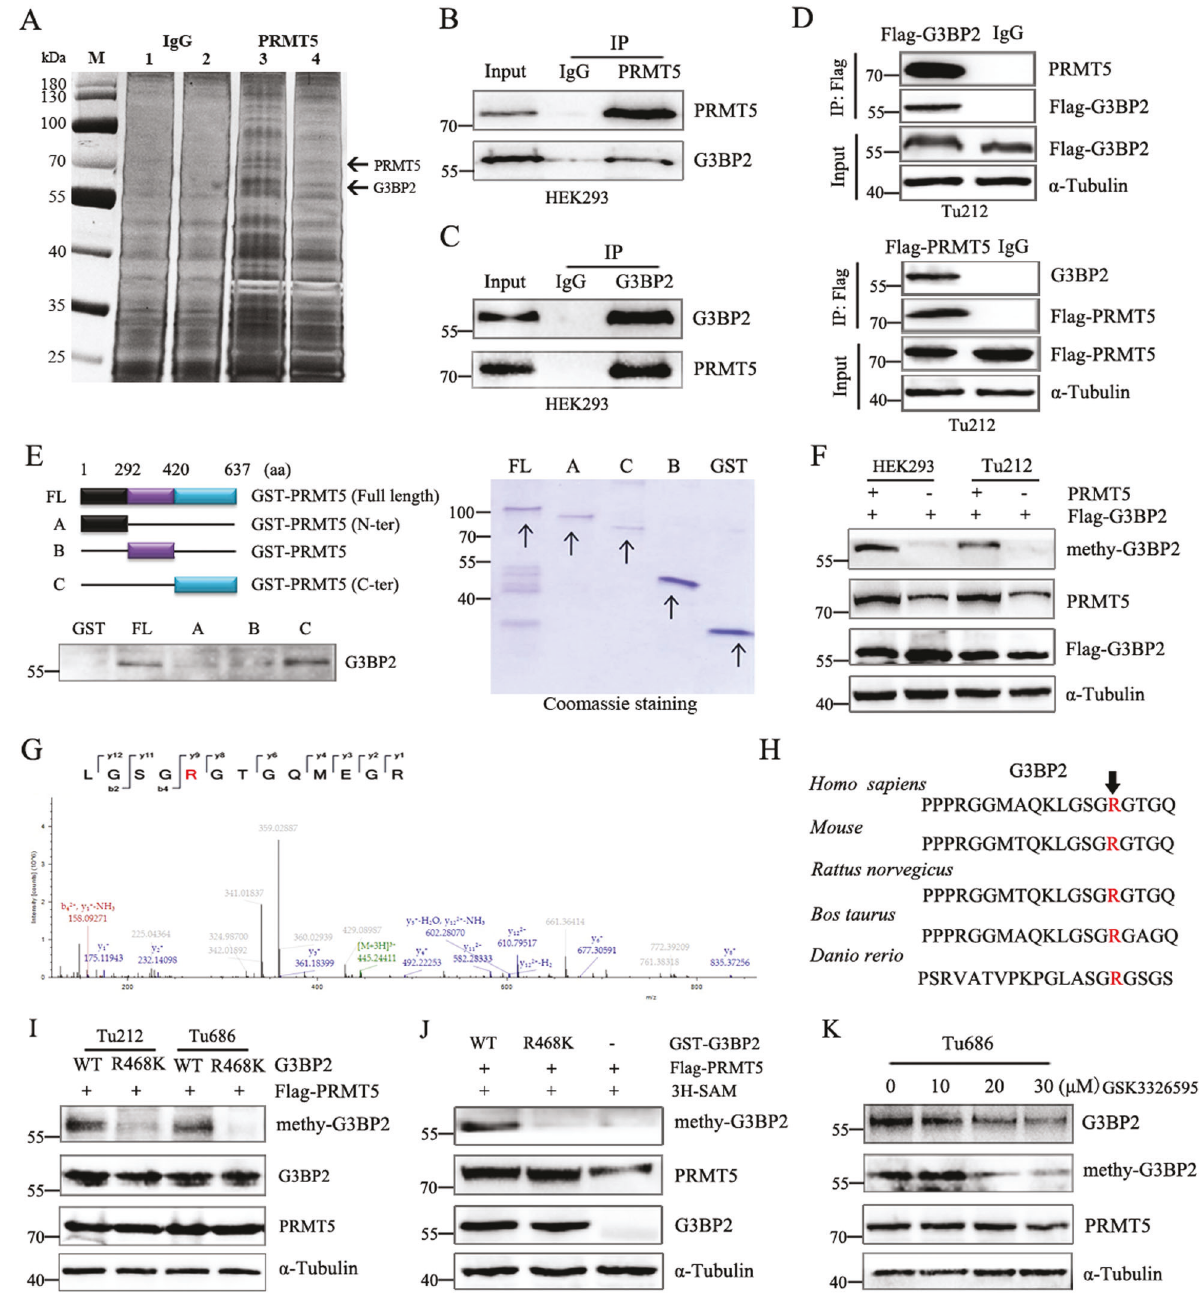
Fig. 1 PRMT5 interacts with and methylates G3BP2. A PRMT5 plasmid was transfected into HEK293 and Tu686 cells. After incubated for 48 h, cell lysates were measured by Immunoprecipitation (IP) assays using anti-PRMT5 beads, and the silver staining showed the location of PRMT5 and its associated protein G3BP2. Lane 1,3 for HEK293 cell. Lane 2,4 for Tu686 cell. B , C Co-immunoprecipitation (Co-IP) of PRMT5 and G3BP2 was performed in HEK293 cells. IgG was used as a negative control. D Association of PRMT5 with G3BP2 were veri fi ed by Co-IP assay with anti- Flag in Tu212 cells transfected with Flag-PRMT5 or Flag-G3BP2, respectively. E Schematic diagram showed the structure of PRMT5 (left) and the deletion constructs were co-transfected with Flag-G3BP2 into HEK293 cells. Cell lysates were precipitated with GST beads. G3BP2 was blotted with an anti-Flag antibody. Immunoblotting and Coomassie Brilliant blue staining were shown. F The methylation of G3BP2 was detected by western blot analysis using a custom-made methy-G3BP2 antibody in HEK293 and Tu212 cells transfected with or without PRMT5 plasmid. G Methylation site of G3BP2 was examined by liquid chromatography- mass spectrometry (LC-MS). R represents potential methylation site. H Sequences of the evolutionarily conserved residue R468 (red) in G3BP2. I Validation of R468 as the PRMT5-catalyzed G3BP2 methylation site in Tu212 and Tu686 cells. J In vitro methylation of G3BP2 in the presence of 3 H-SAM. Recombinant GST-G3BP2-WT and G3BP2-R468K proteins were puri fi ed from bacteria and Flag-PRMT5 proteins were immunopuri fi ed from HEK293 cells. K Tu686 cells were treated with the indicated amounts of GSK3326595 for 24 h, protein levels of G3BP2 and methy-G3BP2 were assessed by western blot.